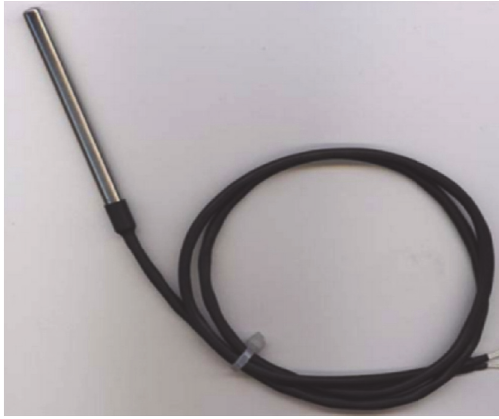
Figure 3: Four-wire PT100 temperature